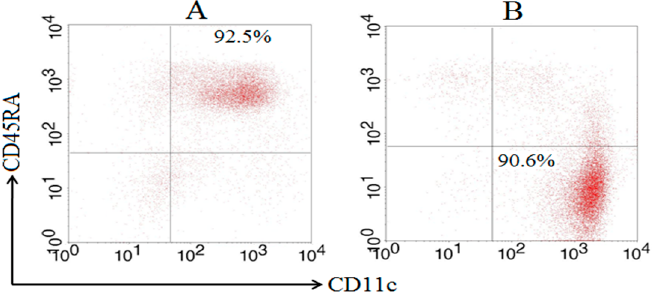
Figure 1. Purity of splenic cDCs and pDCs after MACS sorting based on FACS. Splenic pDC was